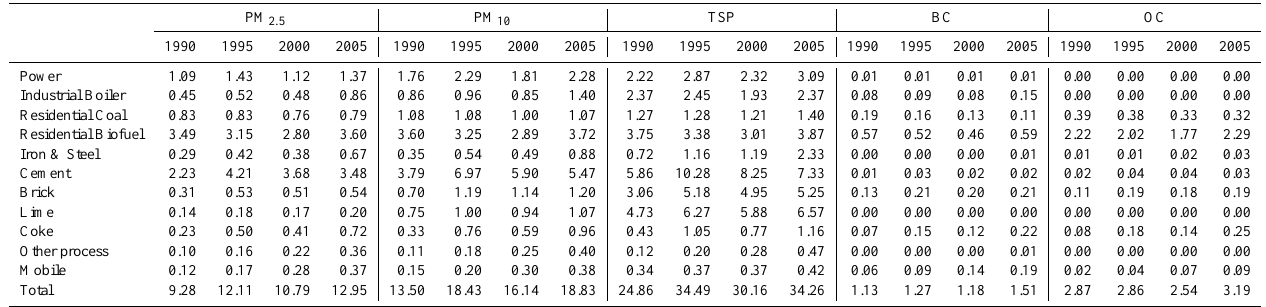
PM 2 . 5 PM 10 TSP BC OC